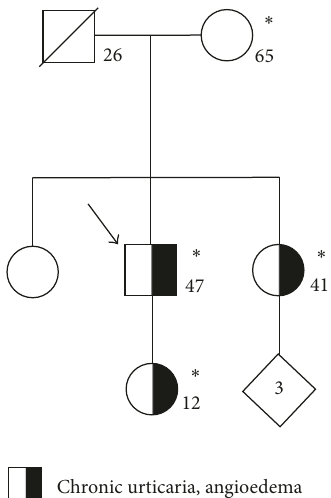
Figure 1: Family pedigree. Standard pedigree symbols are used. An arrow indicates the proband. The numbers inside the symbols represent the number of family members. The numbers at the right lower side of the symbols represent current age or age at death of the individuals. Asterisks indicate individuals that underwent whole exome